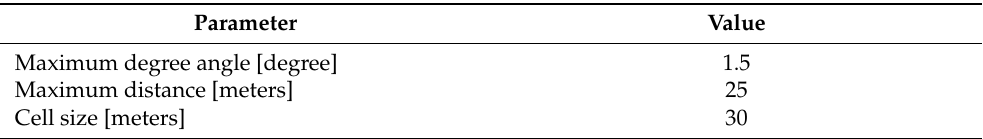
Table 3. The parameter set of the ground classification algorithm. Maximum degree angle describes the maximum slope of the study area expressed in degrees; maximum distance is the maximum distance between the ground and the highest feature in the scene; cell size is the size of the most extended cell in which there are no detectable ground points (i.e., very dense woods, big buildings). Parameter Value Maximum degree angle [degree] 1.5 Maximum distance [meters] Cell size